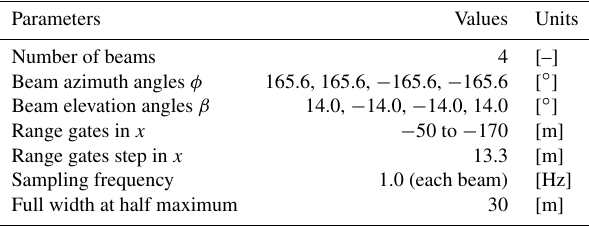
Table 3. Parameters of the optimal four-beam pulsed lidar system. Optimized according to the measurement coherence bandwidth us- ing the space–time tensor model. The definitions of the angles are shown in Fig. 3.